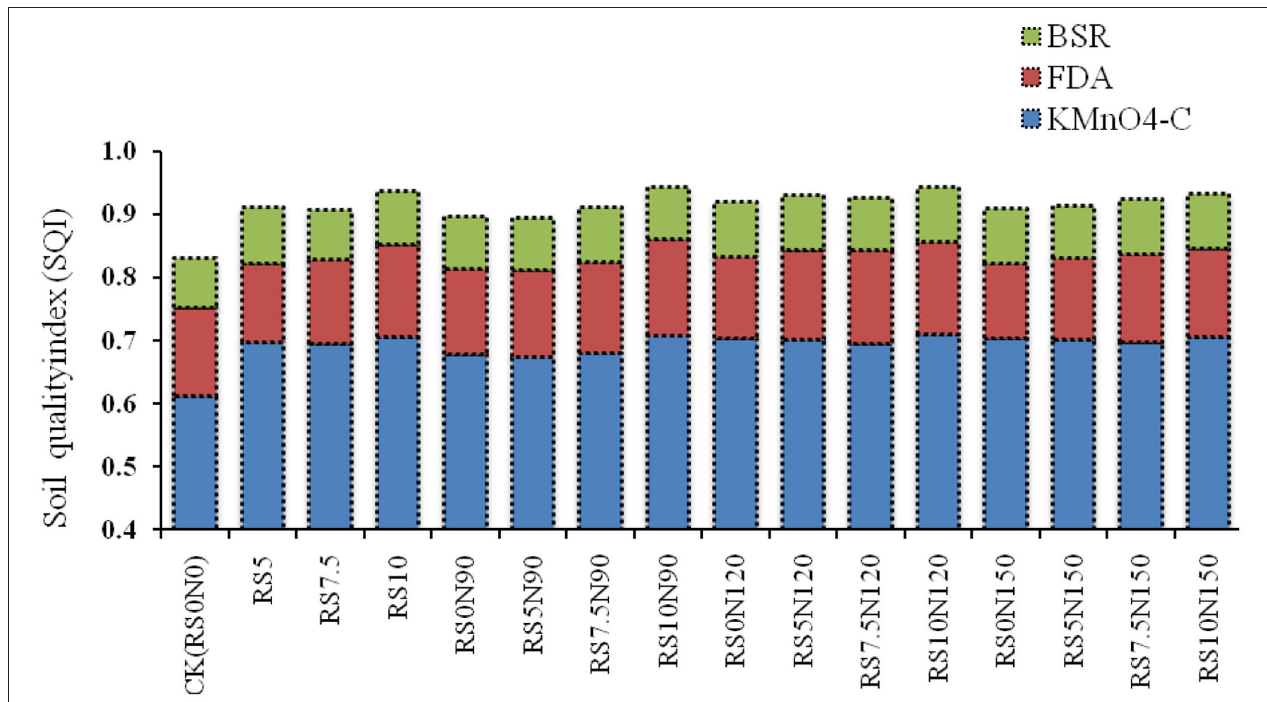
FIGURE 6 | Average effect of fertilizer-N application and rice straw (RS) incorporation on soil quality index (SQI) and the individual contribution of key indicators (KMnO 4 -C, Potassium permanganate oxidizable carbon; FDA, Fluorescein diacetate activity; and BSR, Basal soil